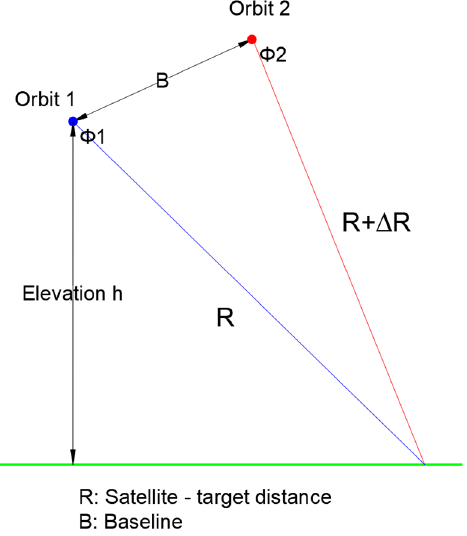
Figure 4. Satellite positions and calculation of the phase difference. Source: ESA-TOPS Interferometry Tutorial.